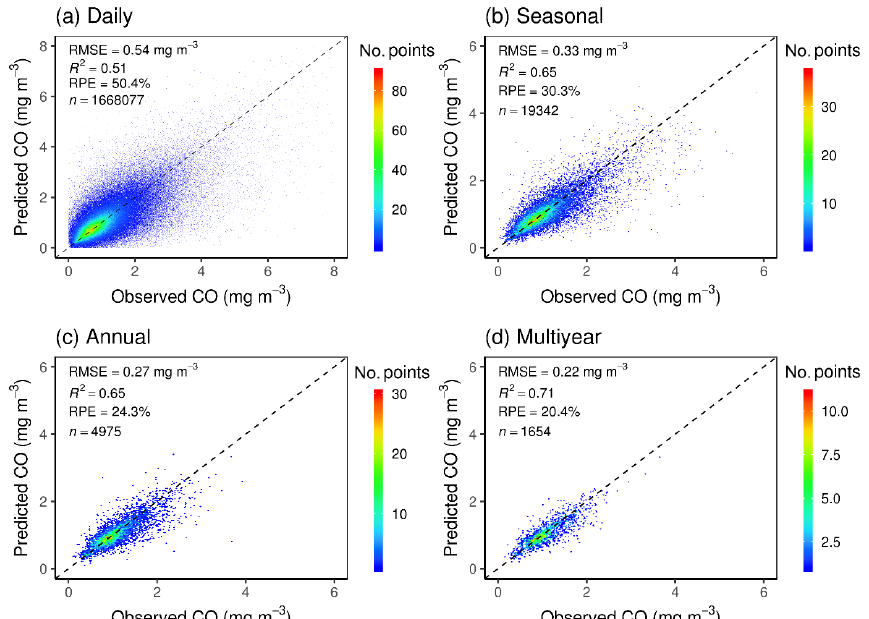
Figure 5. Performance of the RF–STK model in predicting (a) daily, (b) seasonal, (c) annual, and (d) spatial (i.e., multiyear average) ground-level CO concentrations across China during 2013–2016. The dashed lines represent the 1 : 1